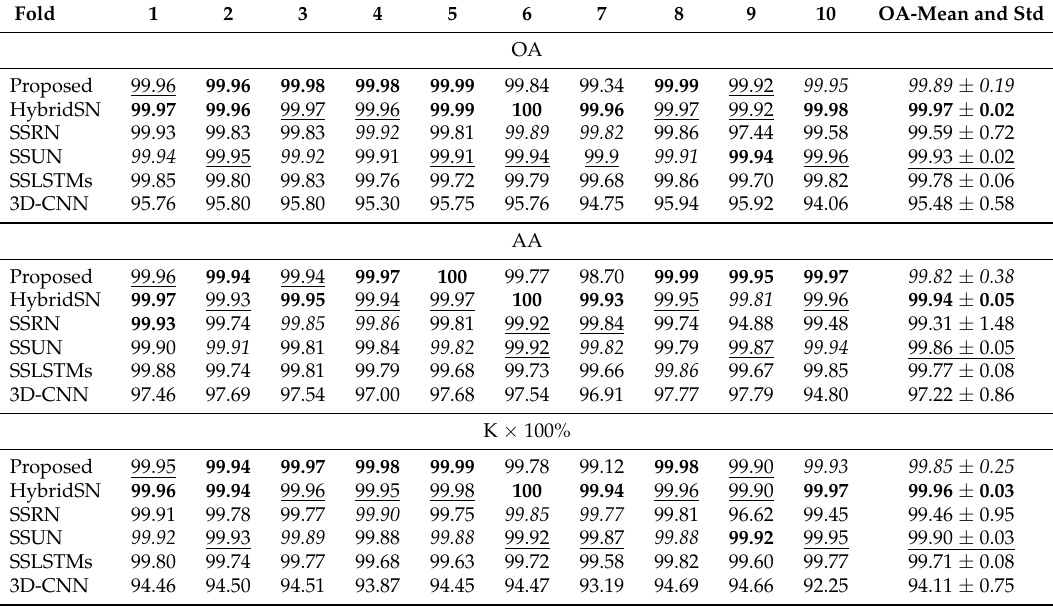
Table 10. Fold Overall Accuracy, Average Accuracy, and Kappa Value on PU dataset with 30% training data. The best performance is in bold, the second-best performance is underlined, and the third-best is in italic.